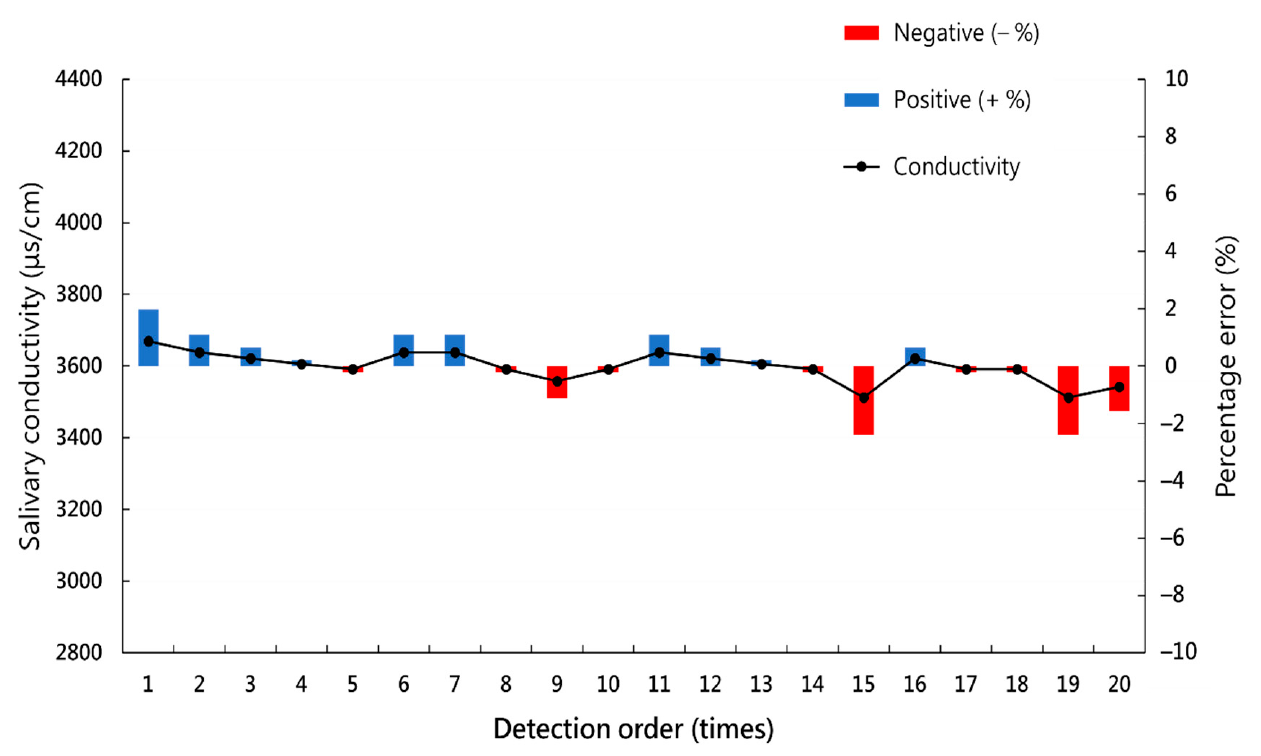
Figure 3. Serial measurements of the salivary conductivity of the same saliva sample 20 times.